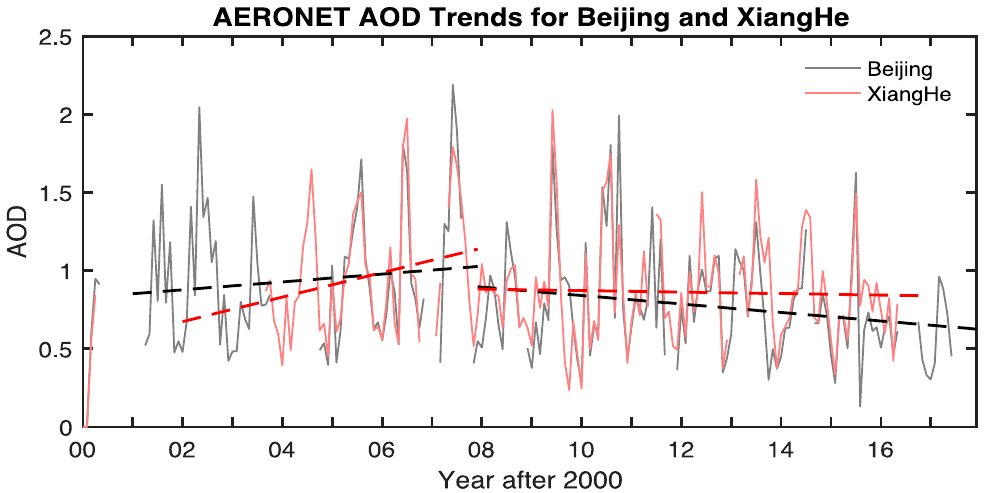
Figure 3. AERONET AOD time series and linear trends for Beijing and XiangHe. The dashed lines indicate linear trends fitted for the 2000–2007 and 2008–2017 periods using the Sen’s slope method. All trends were significant at 95% according to the Mann–Kendall test. Remote Sens. 2020 , 12 , x FOR PEER REVIEW